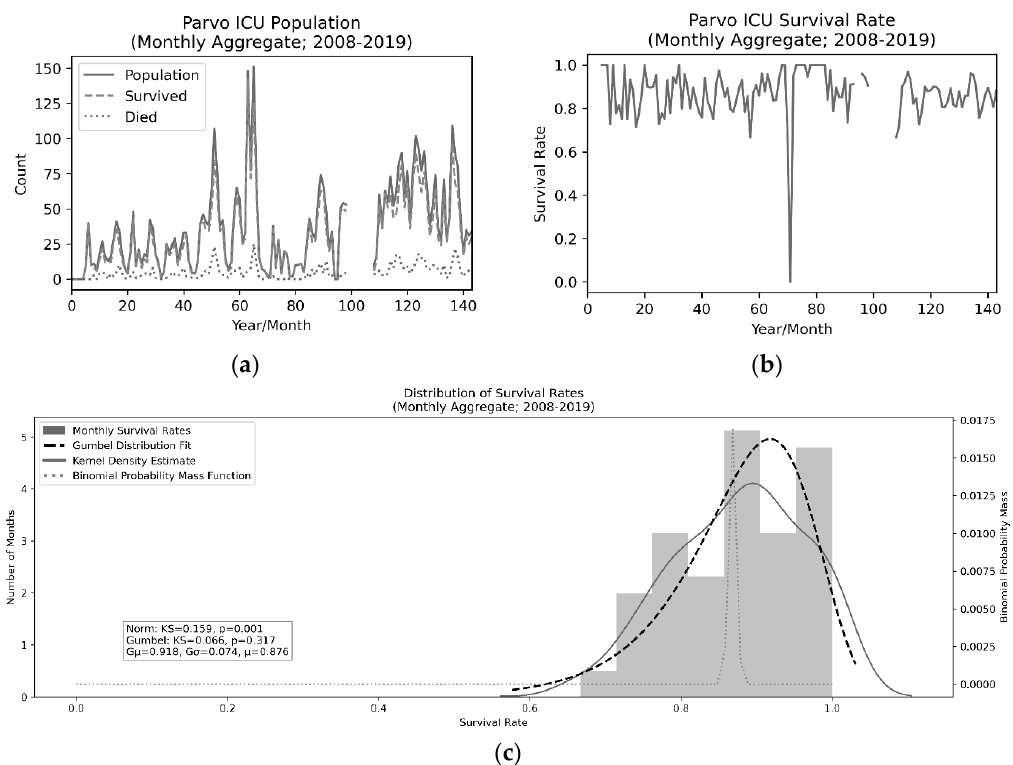
Figure 1. Population values ( a ), survival rates ( b ), and distributional properties ( c ) of canine parvovirus (CPV)-infected dogs from July 2008 to December 2019. The expected survival rates are approximately 86.6% and there is no evidence for a relationship to the overall population occupying the intesive care unit